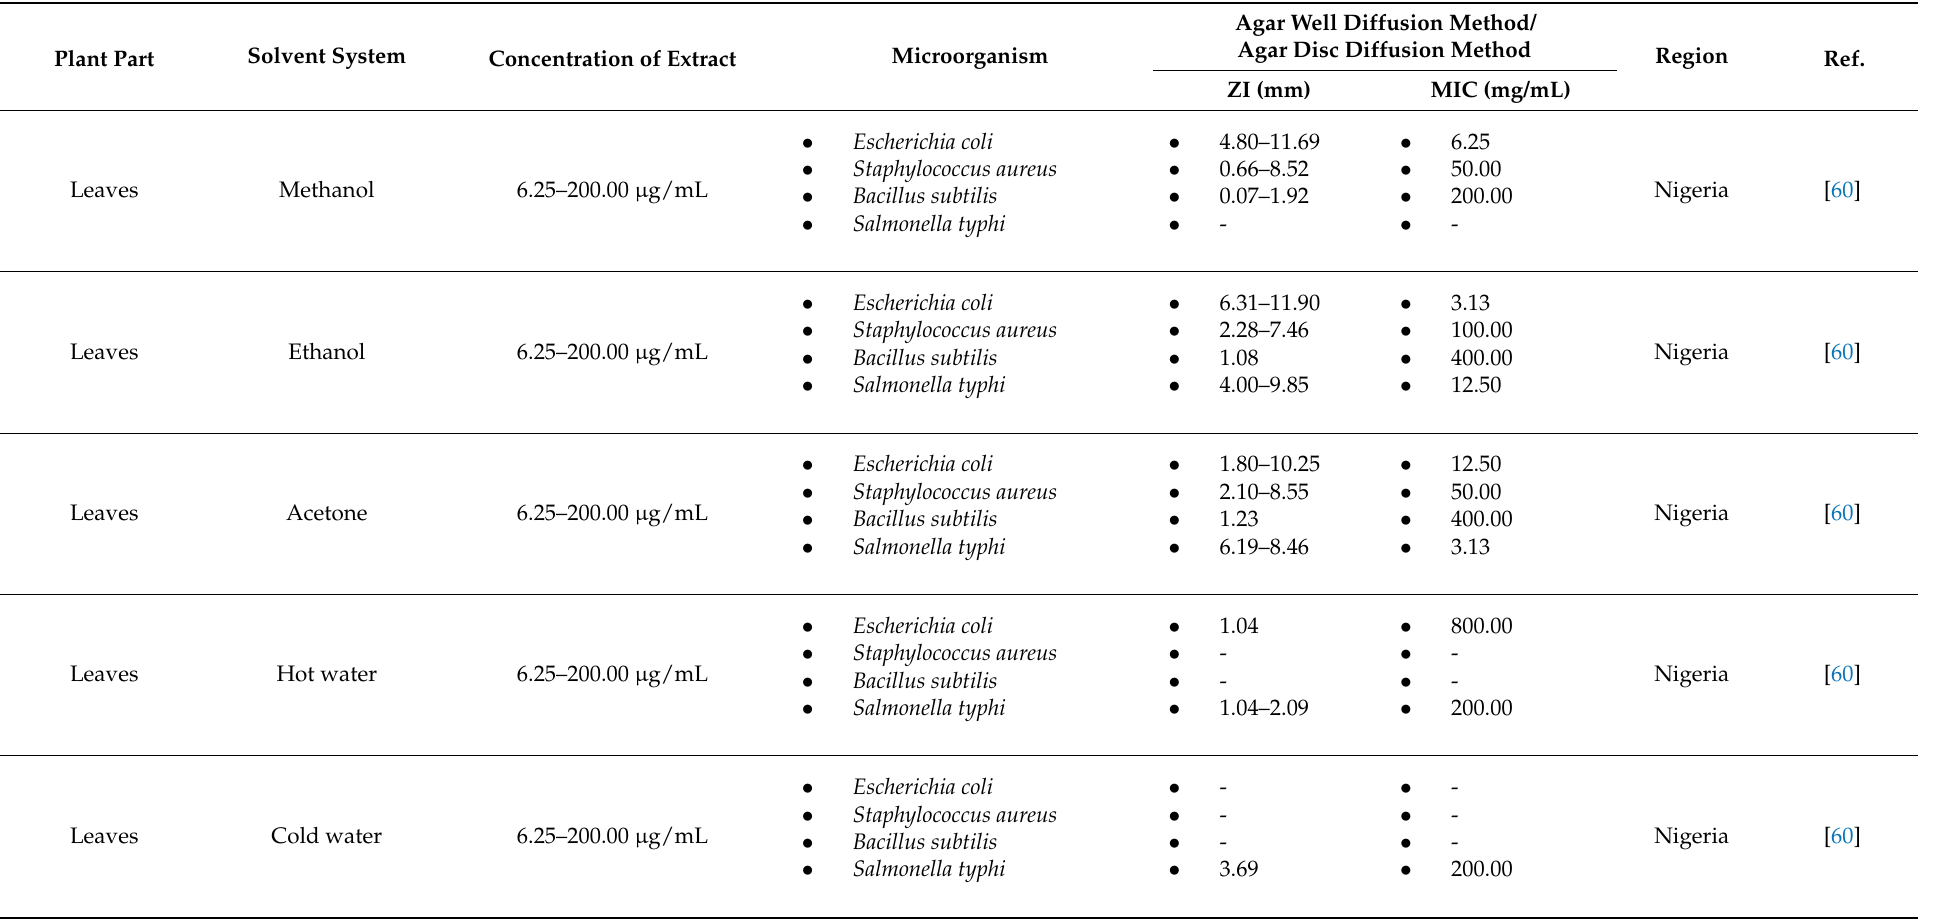
Table 9. Antibacterial activity of Cajanus cajan